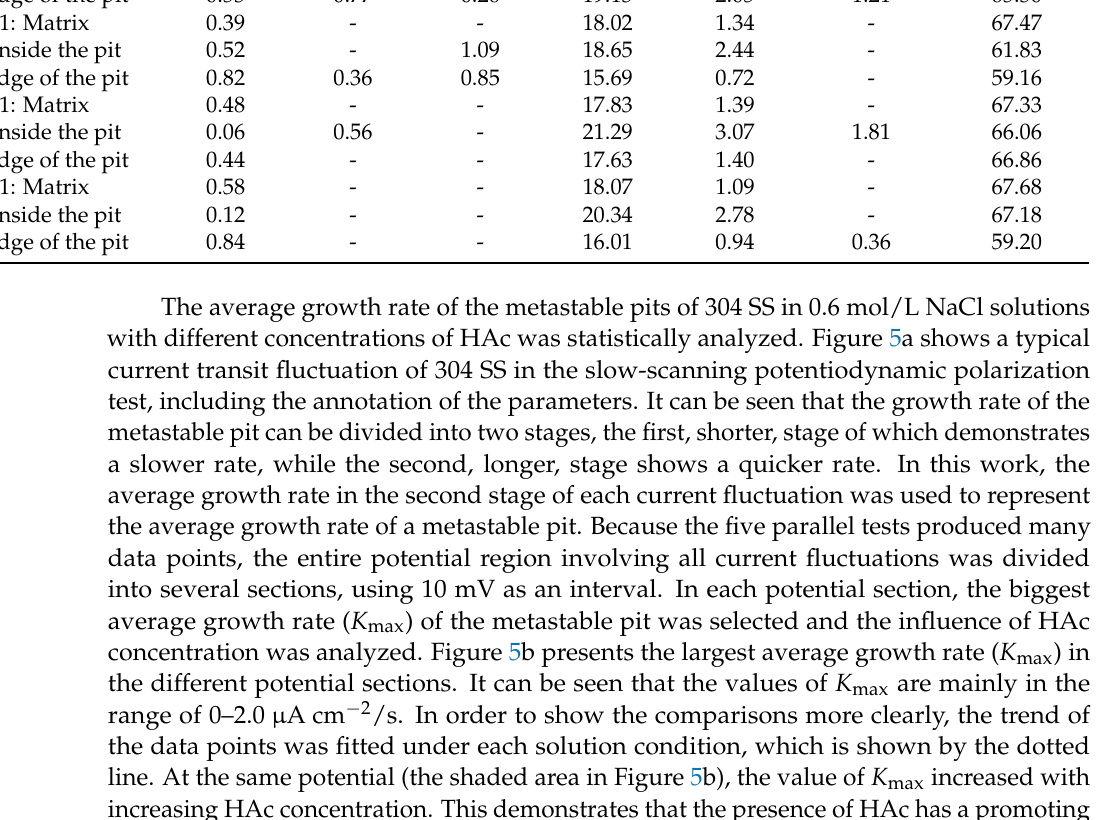
Table 2. EDS results of the metastable pits of 304 SS in 0.6 mol/L NaCl solutions with HAc.